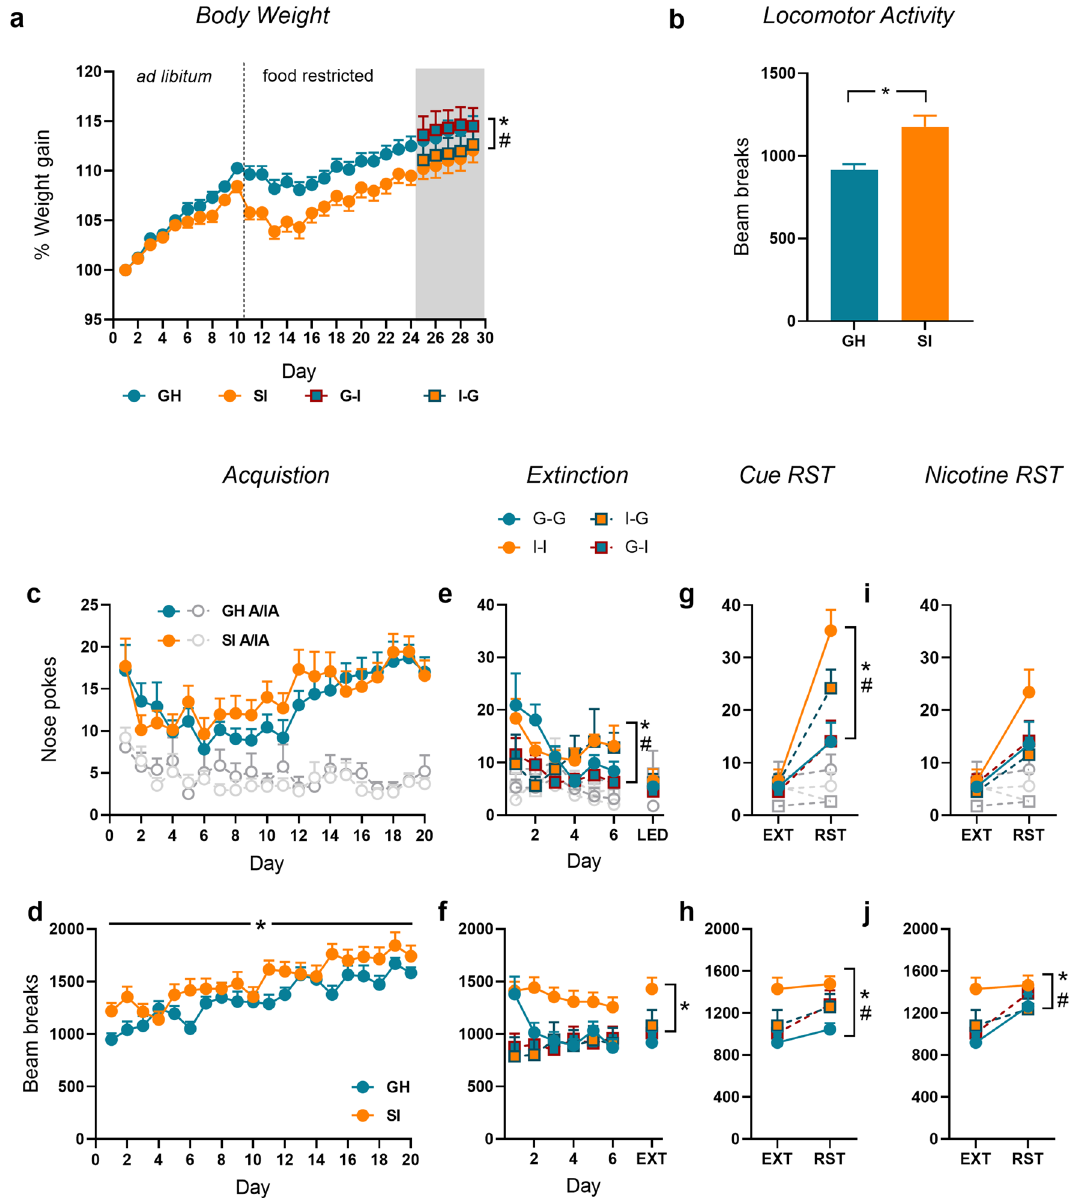
Figure 5. Experiment 4: The effect of reversing housing condition on acquisition versus reinstatement of responding for intravenous nicotine. ( a ) Percentage weight gain across the entire study, including when food was freely available (ad libitum), when food was restricted prior to operant training (food restricted) and with a change in housing condition (grey area). ( b ) Spontaneous locomotor activity during habituation to the instrumental chambers. Active (colour) and inactive (grey) nose-pokes and locomotor activity across acquisition ( c , d ), extinction training ( e , f ), cue-reinstatement ( h , i ), and nicotine reinstatement ( j , k ). GH group housed, SI socially isolated. GH/G–G group housed, SI/I–I socially isolated, G–I initially group housed, isolated after acquisition, I–G initially socially isolated, returned to group housing after acquisition. LED Last extinction day, EXT extinction, RST reinstatement. Symbols indicate effect or interaction including initial housing (*) or housing following the switch (#) where p < 0.05. n =